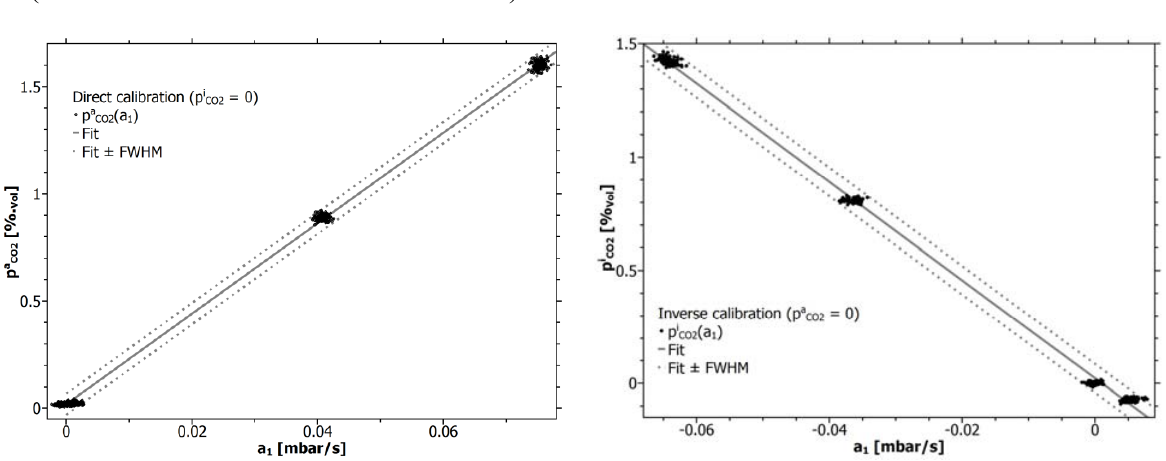
–C ) for calibration, response a 1 4